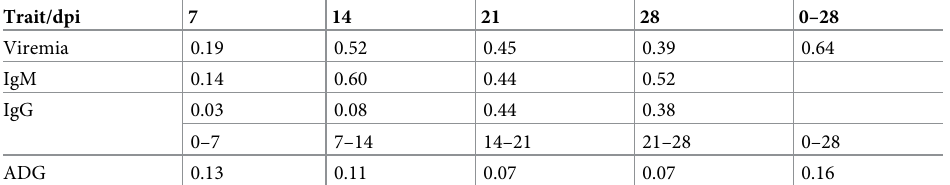
Table 1. Proportion of phenotypic variance explained by SNPs from Porcine SNP60 BeadArray using BayesB of PCV2-related traits days post infection (dpi) with PCV2.